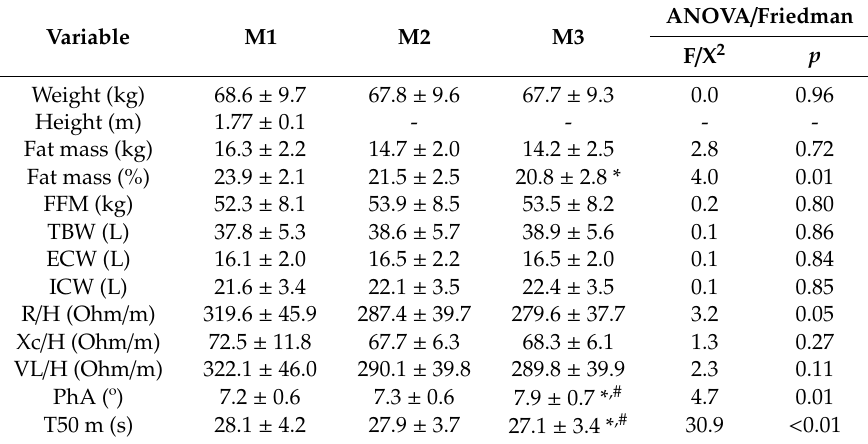
Table 1. Changes in body composition, bioelectric and performance variables, from the beginning of the season, to before the beginning of the taper period (M2), and to just before the main competition of the macrocycle (M3) in the swimmers.